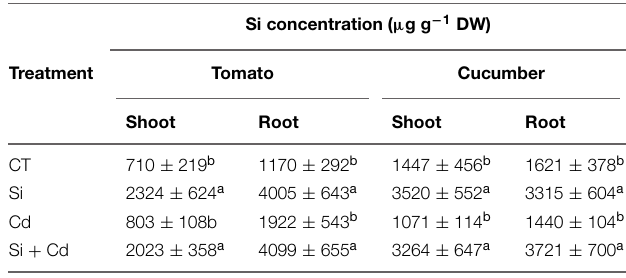
TABLE 1 | Silicon (Si) concentrations in tomato and cucumber as affected by Cd and Si.